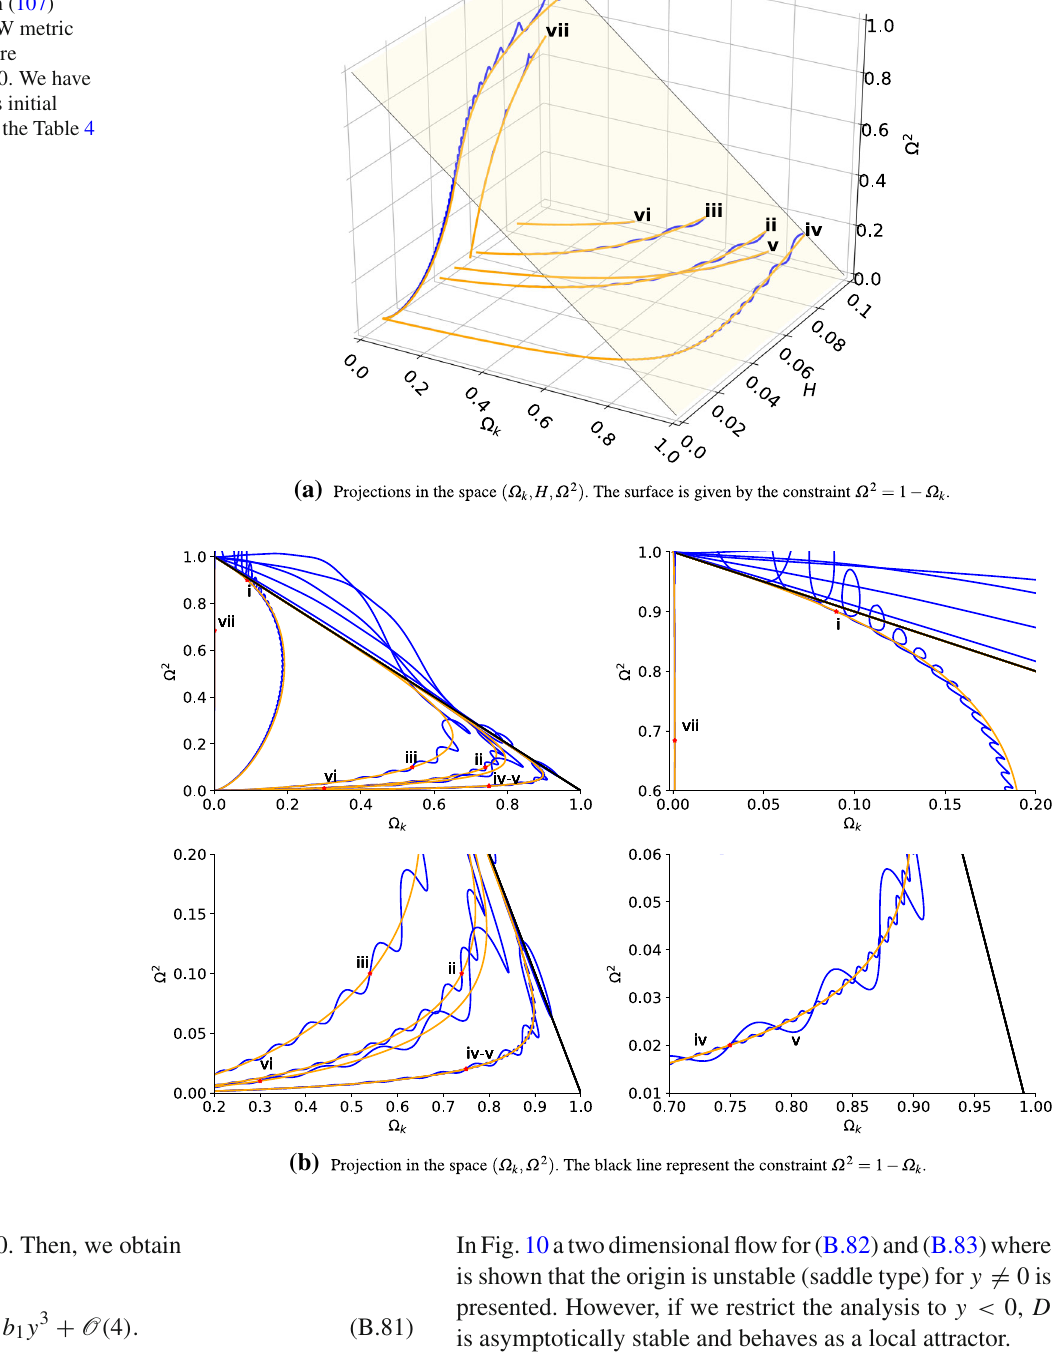
Fig. 21 Some solutions of the full system (71) (blue) and time-averaged system (107) (orange) for the FLRW metric with negative curvature ( k = − 1) when γ = 0. We have used for both systems initial data sets presented in the Table